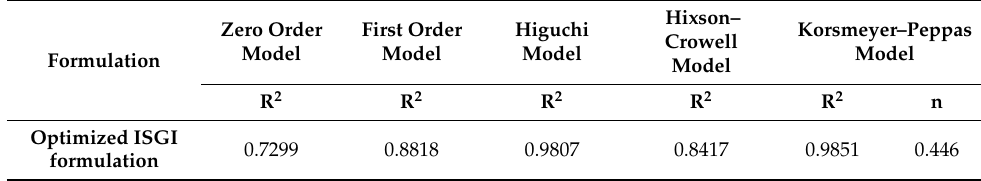
Table 7. Kinetic release study of optimized ISGI formulation.